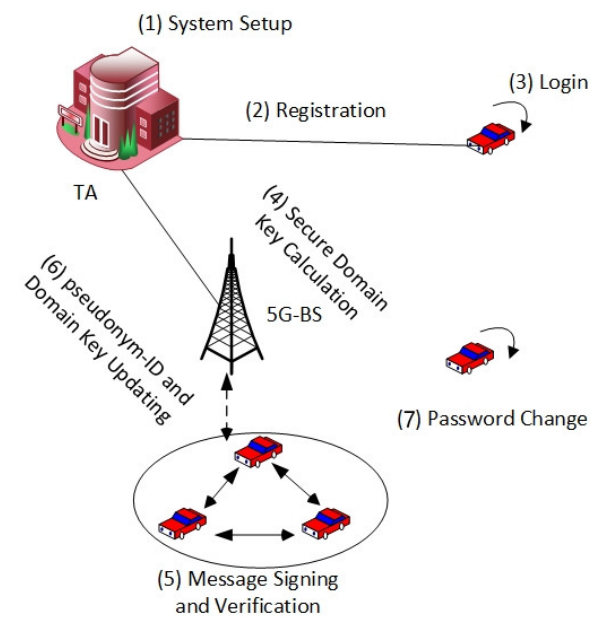
Figure 2. Flow diagram of the proposed